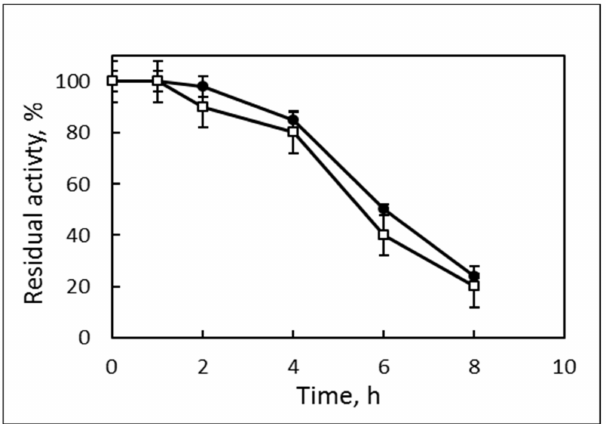
Figure 4. Thermostability of the purified lipase after preliminary incubation at 60 ◦ C for different times (hours). (cid:3) , PE; • , PE + 5mM CaCl 2 . The residual activity was determined at 55 ◦ C.